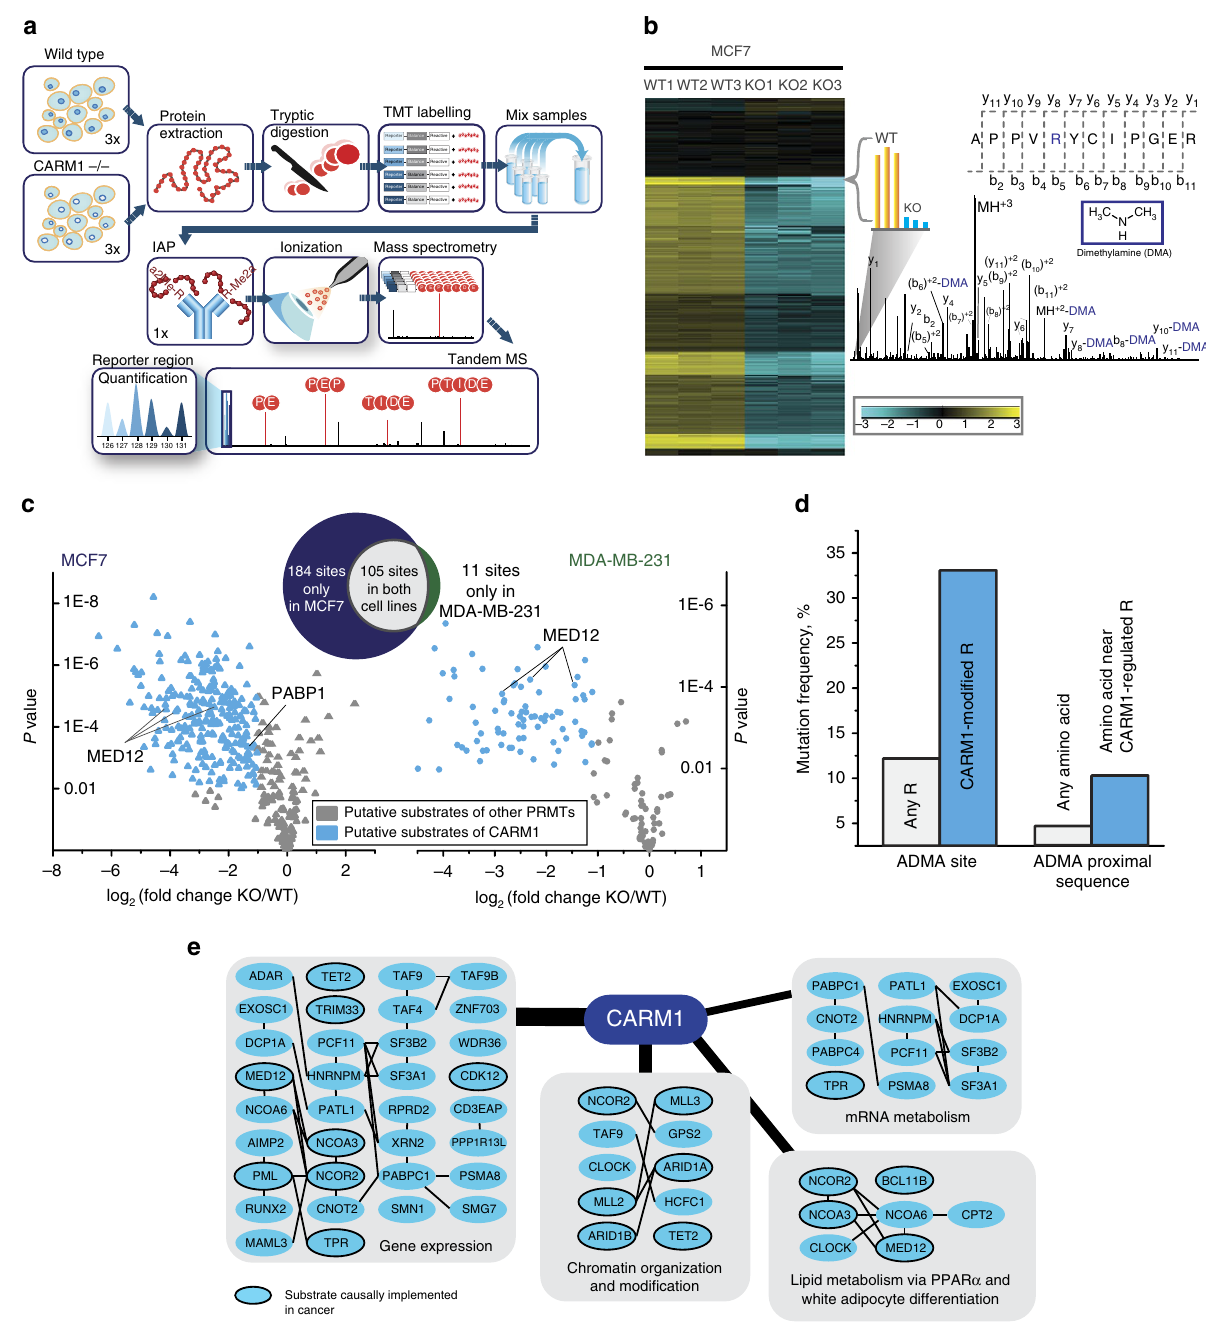
Figure 1 | Global profiling of CARM1 substrates using quantitative mass spectrometry. ( a ) Experimental workflow for global detection of CARM1 substrates. Enrichment of ADMA—containing tryptic peptides from three biological replicas of parental and CARM1 KO cell lines—was followed by quantitative mass spectrometry using TMT. ( b ) Identification and quantification of ADMA-containing peptides and sites. The heat map displays hierarchical clustering using Pearson correlation of mean normalized log 2 transformed intensities of ADMA containing peptides in three biological replicas of parental MCF7 and CARM1 KO cells. ATMTreporter region of the spectrum is magnified as an example. The spectrum also illustrates the neutral loss of DMA, characteristic of asymmetric but not symmetric dimethylarginine modification that was used for peptide identification and ADMA site mapping. ( c ) Identification of putative CARM1 substrates from two breast cancer cell lines using three biological replicas of each sample. Volcano plots illustrate changes in ADMA peptide abundances in MCF7 (left) and MDA-MB-231 cells (right). Greater than twofold reduction on CARM1 loss and maximum P value of 0.01 (two-tailed Student’s t -test) were set as the threshold criteria for putative CARM1 substrates. The known CARM1 protein substrates, MED12 and PABP1, were identified among 4 130 previously unreported ones. ( d ) Rates of somatic mutations at and nearby CARM1 methylation sites in human cancers. Frequencies of non-synonymous single nucleotide variants at or in the proximity of CARM1-regulated ADMA sites ( ± 5 nucleotides) were over twofold higher than those of non-modified arginines or a randomly selected residue (Fisher’s exact test P values of 5.6e-31 and 7.8e-24, respectively), according to the COSMIC. ( e ) Substrate interaction diagram (STRING 10.0) featuring four biological pathways (Reactome 2016) strongly enriched for the presence of putative CARM1 substrates (combined score 4 5). Thickness of the lines radiating from CARM1 correlates to the pathway enrichment score (Supplementary Table 3). A black frame around a substrate indicates its causal implementation in cancer (COSMIC). NATURE COMMUNICATIONS|8:15571|DOI: